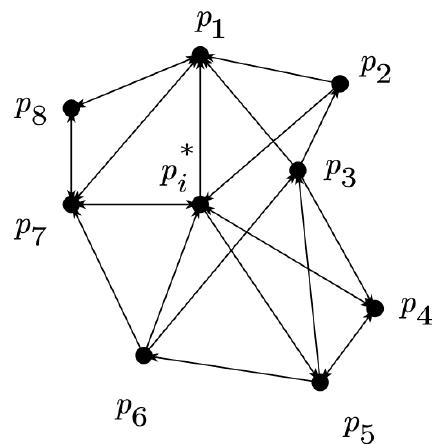
Figure 1. An example of a learned graph structure.